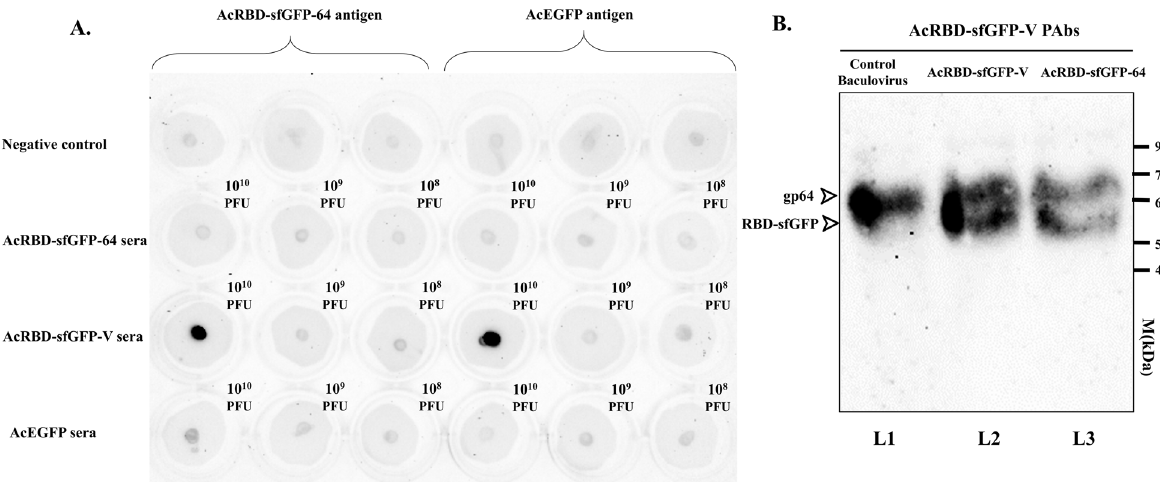
Fig. 2 Production of polyclonal antibody by the pseudotyped virus from immunized BALB/C mice. a The virus displaying RBD produced antibodies that can bind both RBD and gp64 protein at 10 10 pfu/ml in a serum sample obtained from mice injected with AcRBD-sfGFP-V subcutaneously without any adjuvant. b Western blot of the AcRBD-sfGFP-64, AcRBD-sfGFP-V, and the AcDH10Bac detecting differences between the RBD-sfGFP and gp64 bands. Two distinguished bands corresponding to gp64 (~67 kDa) and RBD-sfGFP (~ 51 kDa) were observed in both AcRBD-sfGFP-64 and AcRBD-sfGFP-V samples but only a single band corresponding to gp64 was observed in the AcDH10Bac